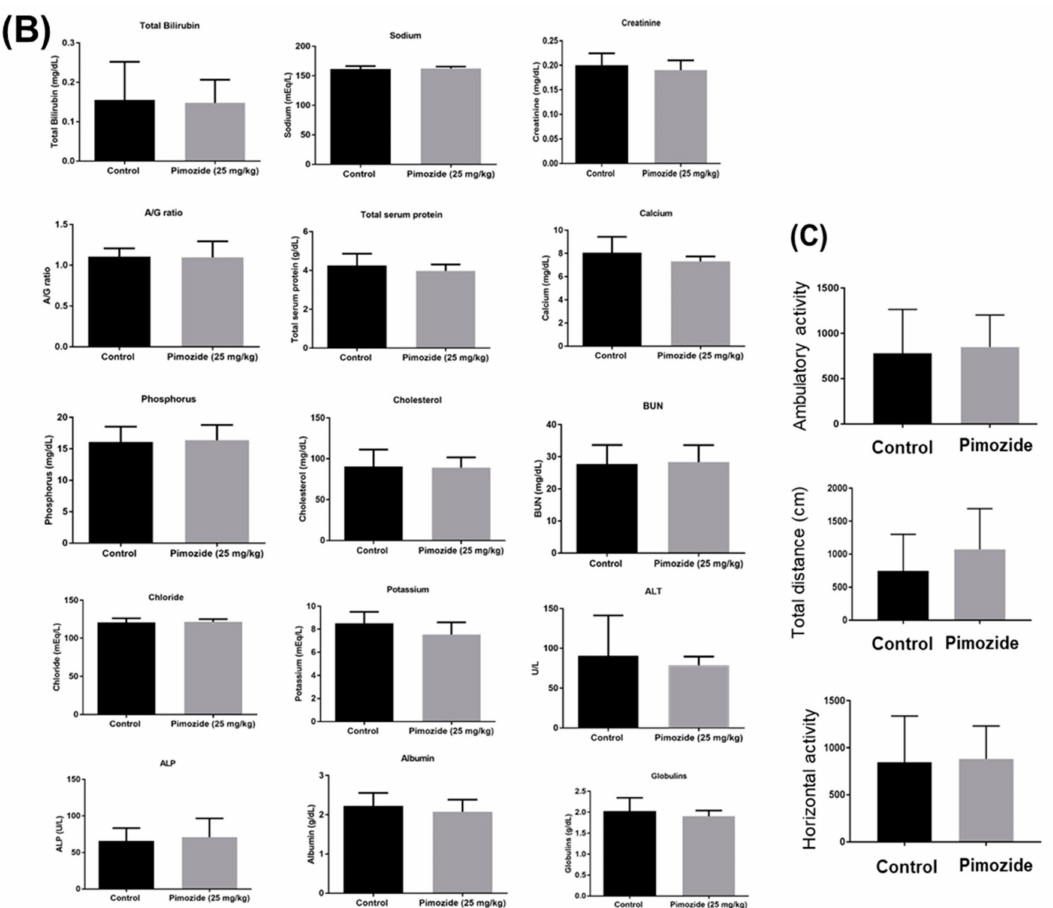
Figure 10. Safety profile study in mice. About 0.15 million U-87 MG cells were implanted intracranially in the brain of 4–6-week-old female athymic nude mice. Once tumors achieved a minimum size, 25 mg / kg pimozide by oral route was administered every day to mice. ( A ) Mice were observed for general signs of toxicity, and their organ weight was measured in comparison with the control